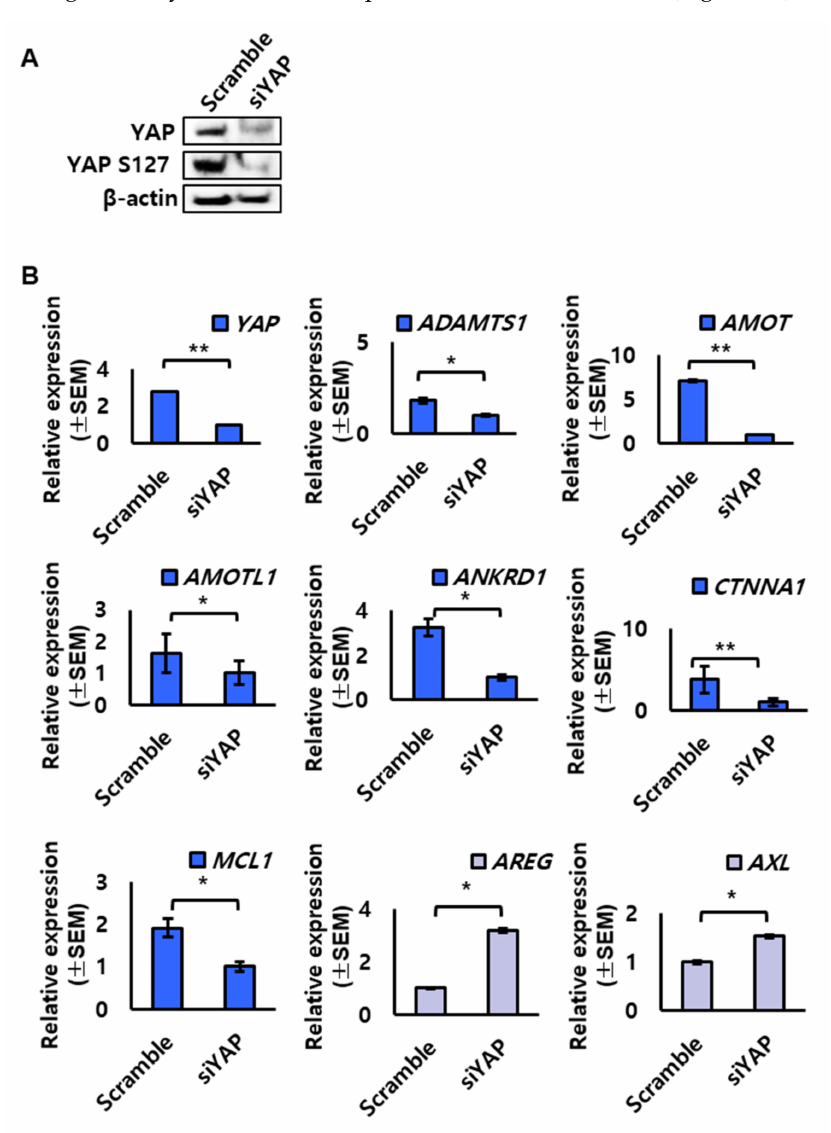
Figure 5. The expression of YAP target genes in endometrial cells with YAP knockdown. ( A , B ) YAP mRNA and protein were extracted from Ishikawa cells transfected with 20 µ M of scrambled